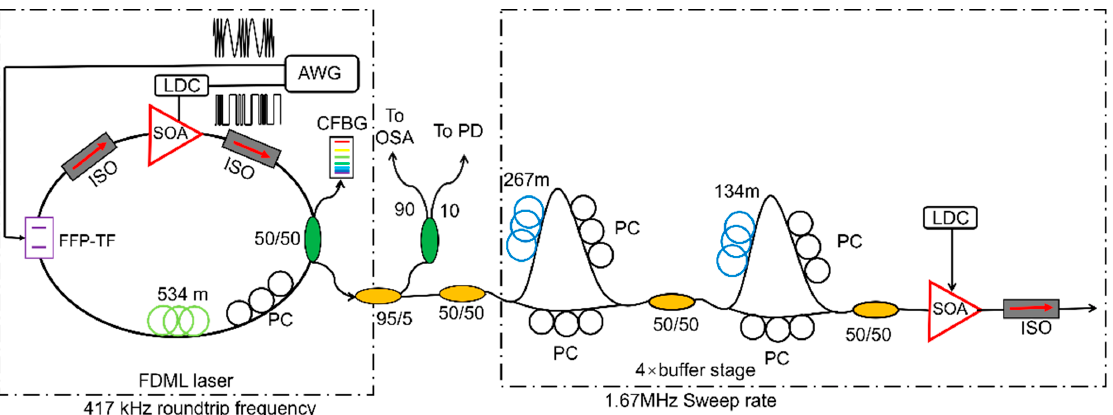
Figure 4. Schematic of an FDML laser with an optional buffer stage: AWG, arbitrary waveform generator; LCD, laser diode controller; SOA, semiconductor optical amplifier; ISO, optical isolator; PC, polarization controller; BFP-TF, Fabry–Pérot filter; OSA, optical spectrum analyzer; PD, photo diode. Adapted with permission from Ref. [42].